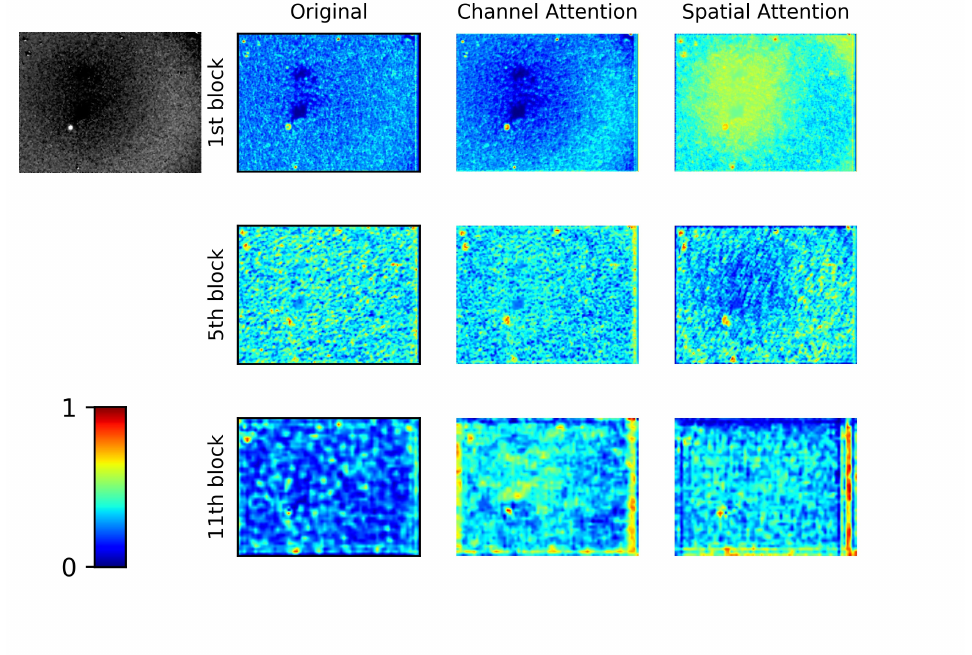
Figure 6. The feature map visualization with different attention blocks of